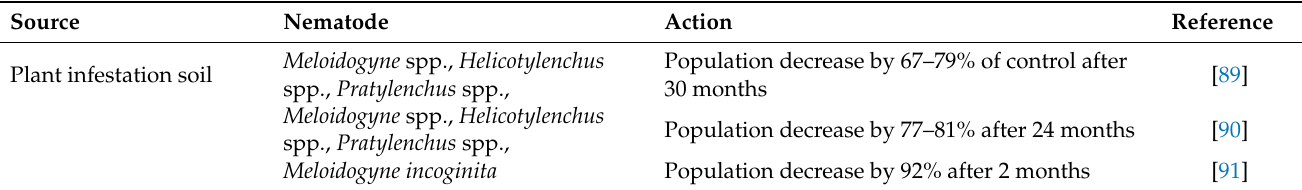
Table 2. Interaction of C. odorata with